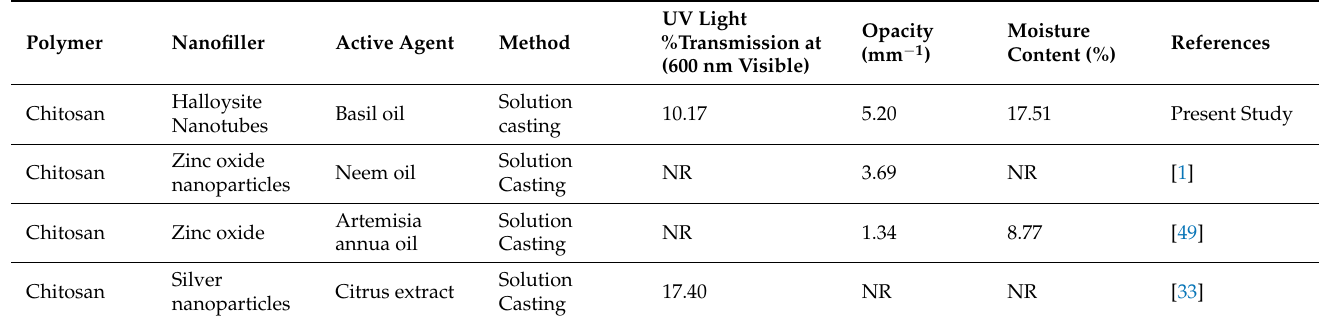
Table 3. Comparative study of active food packaging material with previously reported